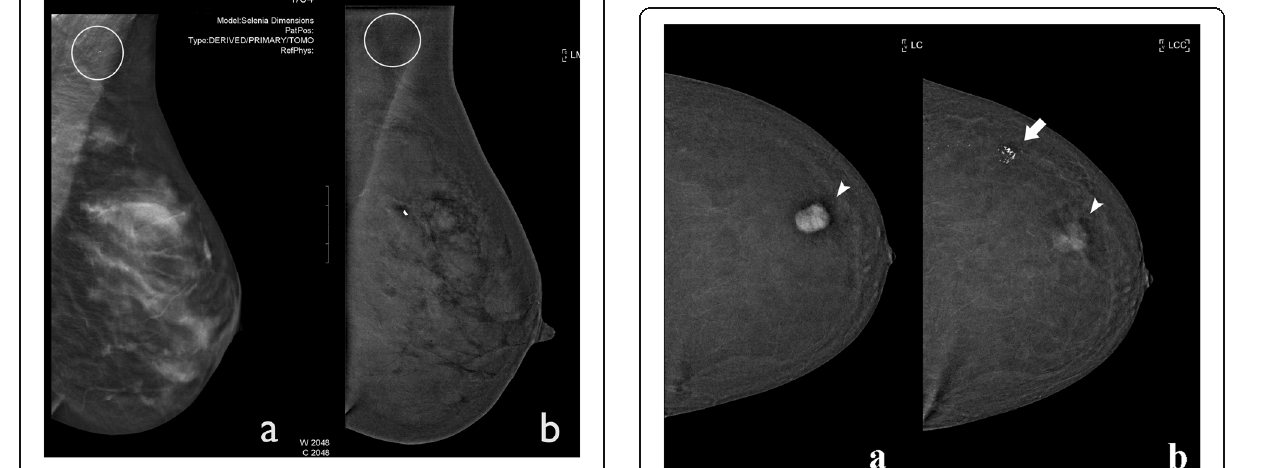
Fig. 3 Antiperspirant artefact. CEDM was performed for staging an IDC in the right breast of a 59-year-old woman. a Left MLO tomosynthesis shows a little white spot in the axillary region caused by the presence of the antiperspirant substance (circle). b The CEDM-recombined image demonstrates that antiperspirant is barely perceptible as a small, black dot (circle)